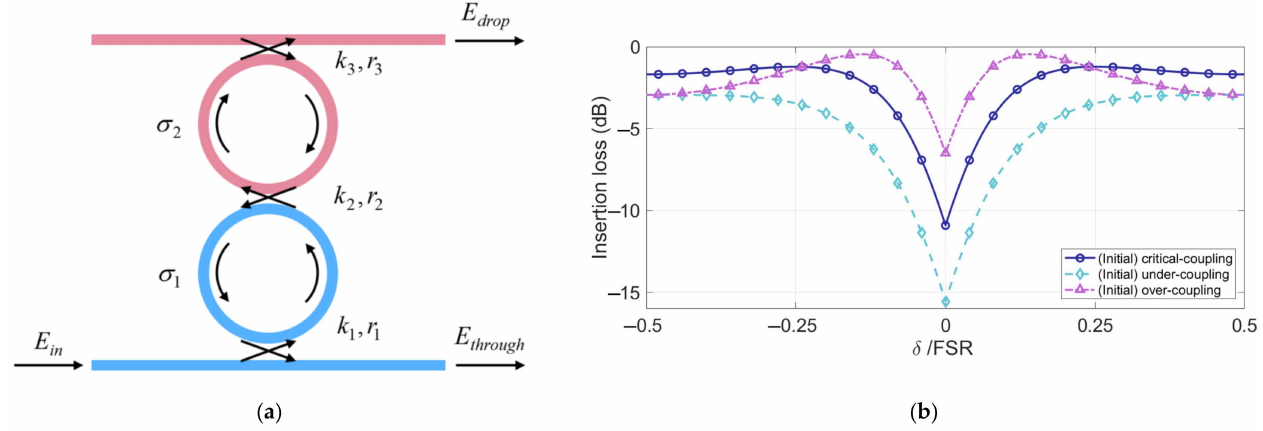
Figure 3. Impact of different coupling states on the system insertion loss. ( a ) Proposed device structure under the transfer matrix method (TMM). ( b ) The insertion loss of the drop port as a function of δ / FSR under different initial coupling